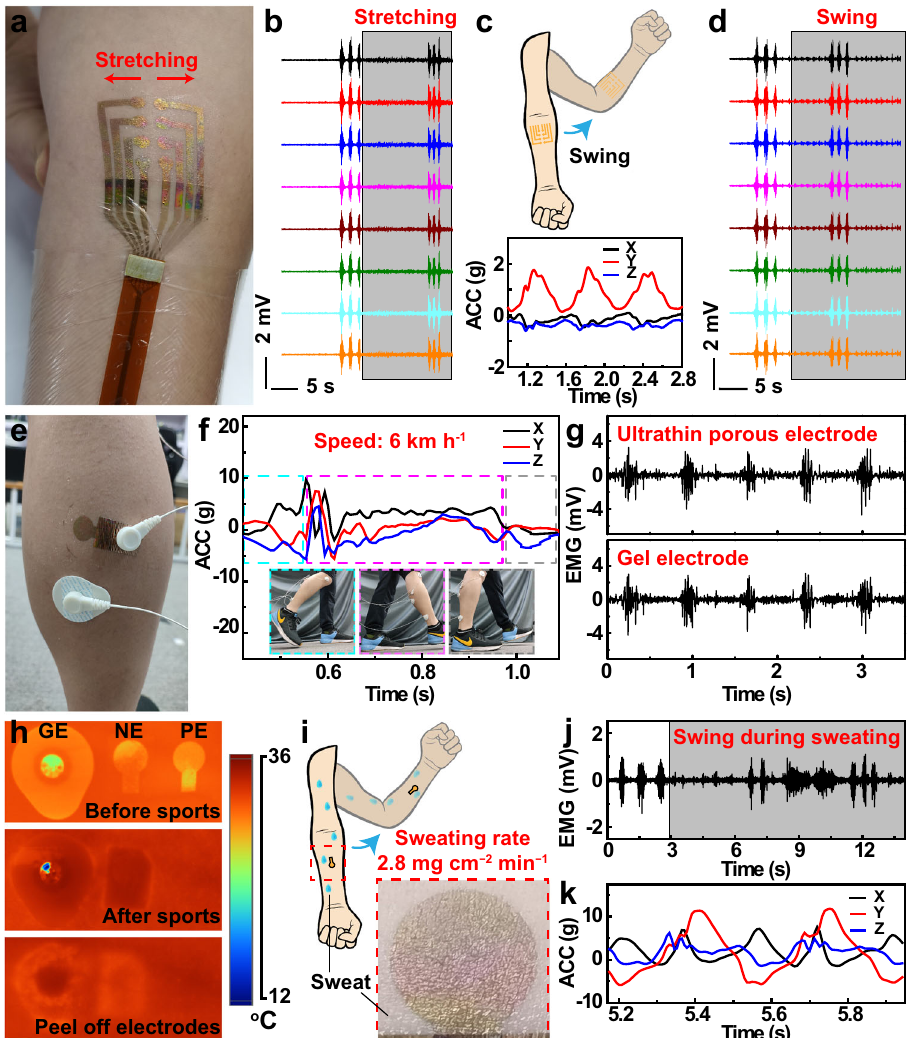
Fig. 5 EMG tests. a Photograph of the stretching electrode − skin interface. b EMG signals during the stretching process. c Schematic illustration showing the swinging arm and its acceleration. d EMG signals during the arm swinging process. e Photograph of the ultrathin porous electrode attached to the leg. f Acceleration of the leg when running at a speed of 6 km h − 1 . g EMG signals detected by the SEBS- based ultrathin porous electrode and the gel electrode during running. h Temperature change of the gel electrode (GE), the nonporous ultrathin electrode (NE), and the porous electrode (PE) with thickness of 200 nm when doing sports. i Swinging arm sweats at a rate of 2.8 mg cm − 2 min − 1 . j , k EMG signals and acceleration of the swinging